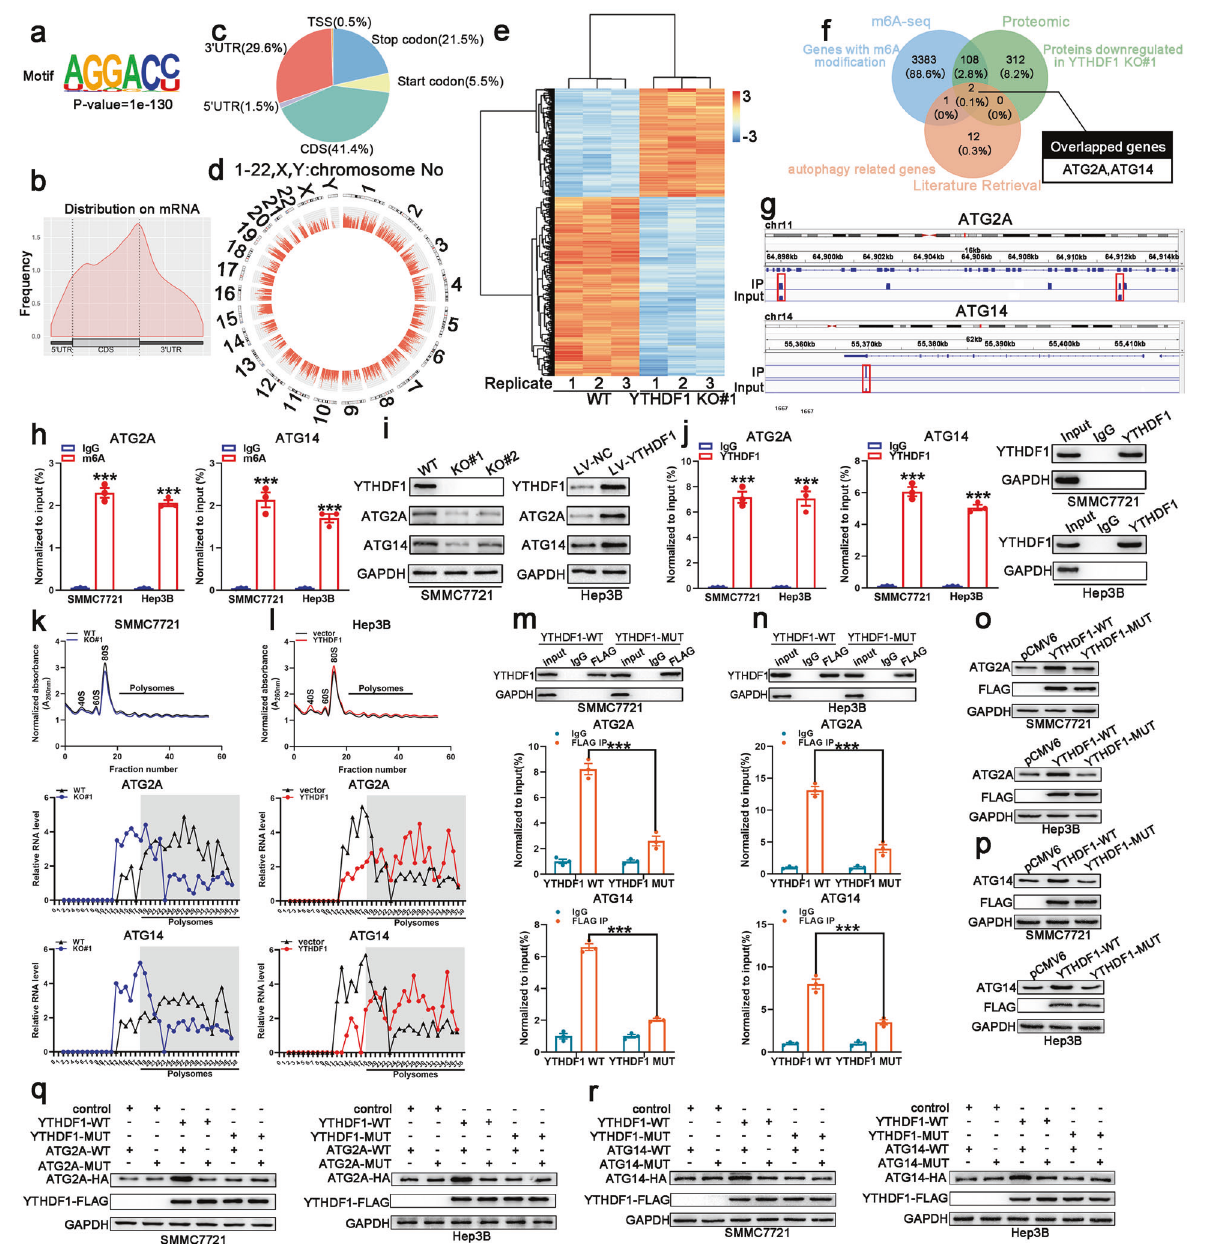
Fig. 5 MeRIP-seq and proteomics identi fi ed potential targets of YTHDF1 in HCC. a m6A motif detected by the MEME motif analysis with MeRIP-seq data in hypoxic SMMC7721 cells. b Metagene pro fi les of m6A enrichment across mRNA transcriptome in hypoxic SMMC7721 cells. c Distribution of m6A sites within different gene regions. d Circos plot displaying the distribution of m6A peaks in the human transcriptome of hypoxic SMMC7721 cells. e Heat map showing the most signi fi cantly altered proteins. f Overlapping analysis of genes identi fi ed by MeRIP-seq, proteomics, and autophagy-related genes. g Integrative genomics viewer (IGV) plots of m6A peaks at ATG2A and ATG14 mRNAs. h Methylated RNA immunoprecipitation of the transcripts of ATG2A and ATG14 in hypoxic SMMC7721 and Hep3B cells. i Validation of ATG2A and ATG14 expression in hypoxic SMMC7721 and Hep3B cells with YTHDF1 knockout or overexpression, respectively. j YTHDF1 immunoprecipitation assays of ATG2A and ATG14 transcripts in YTHDF1-bound mRNAs in hypoxic SMMC7721 and Hep3B cells. k , l Polysome pro fi ling of hypoxic SMMC7721 and Hep3B cells with YTHDF1 knockout ( l ) or overexpression ( l ), respectively (upper panel); qRT-PCR analysis of ATG2A (middle panel) and ATG14 (lower panel) mRNA distribution in different ribosome populations. m RIP-derived protein and RNA in hypoxic SMMC7721 cells examined using western blotting and RT-qPCR, respectively. GAPDH was employed as a negative control in western blotting. n RIP-derived protein and RNA in hypoxic Hep3B cells examined using western blotting and RT-qPCR, respectively. GAPDH was employed as a negative control in western blotting. o , p Analysis of ATG2A and ATG14 expression following overexpression of YTHDF1 wild-type or mutant using western blotting. q , r Western blotting detected HA-tagged ATG2A and ATG14 expression in hypoxic SMMC7721 and Hep3B cells co- transfected with empty vector, wild-type, or mutant FLAG-tagged YTHDF1, and wild-type or mutant HA-tagged ATG14 or ATG2A. Error bars represent the mean ± SEM and the dots represent the value of each experiment; *** P < 0.001